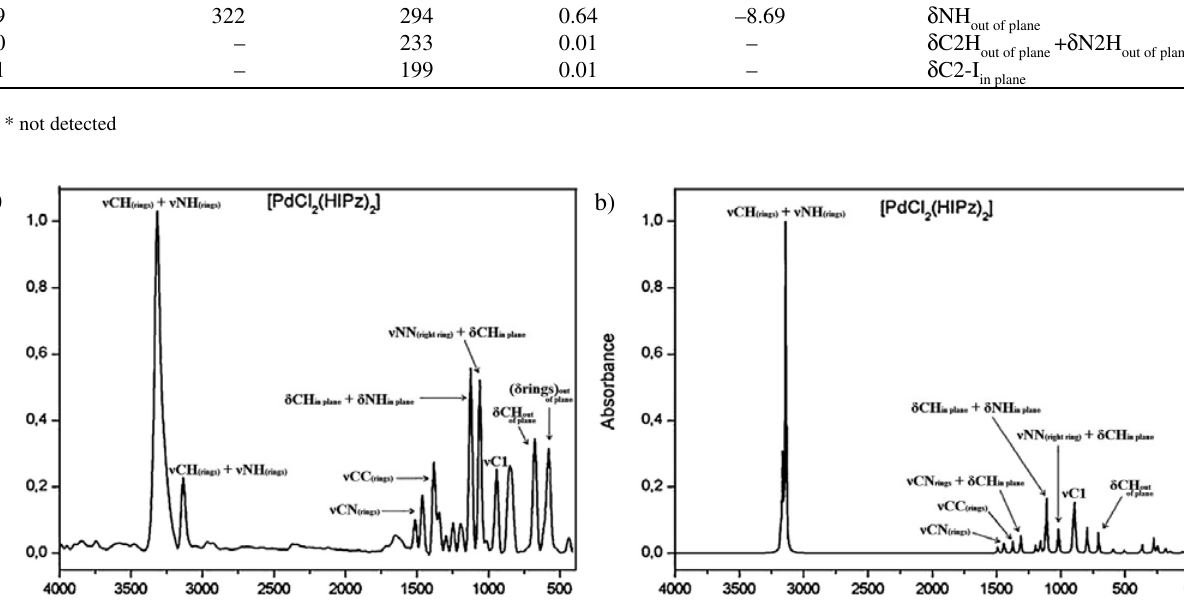
Figure 5. Experimental (a) and theoretical (b) IR spectra of the [ PdCl